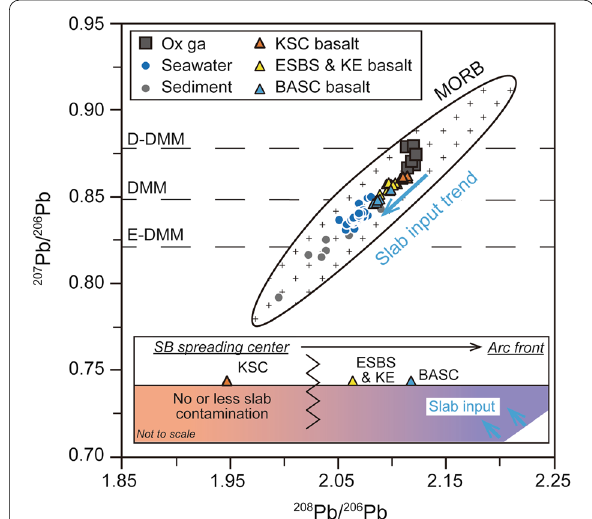
Fig. 10 In‑situ Pb isotope data of magmatic brown amphibole in YK18‑07‑6K‑1515‑R14 oxide gabbro. The inset represents a simplified model of mantle contamination by the input of slab component with the positions of Kian Seamount Chain (KSC), East Shikoku Basin Seamount (ESBS), Kinan Escarpment (KE), and Back‑arc Seamount Chain (BASC) relative to the Shikoku Basin (SB) spreading center and arc front. The pale blue arrow denotes a compositional change by the input of slab component. Measured variability (1SD) is smaller than each symbol size. Pb isotope data of KSC basalts, ESBS basalts, KE basalts, and BASC basalts are from Ishizuka et al. (2009); those of seawaters are from Ling et al. (1997); and those of marine sediments are from Plank and Langmuir (1998). MORB data field is after Stracke et al. (2005). The values of 207 Pb/ 206 Pb in depleted MORB mantle (DMM, a hypothetical source reservoir to MORB) were taken from Workman and Hart (2005). D‑DMM and E‑DMM represent depleted DMM and enriched DMM, respectively (Workman and Hart,